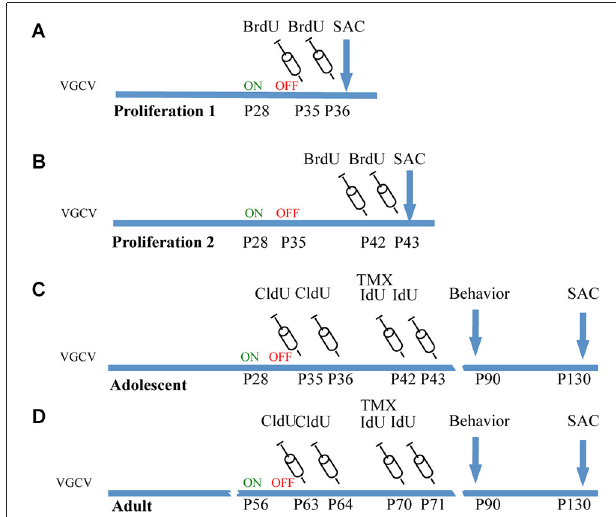
FIGURE 1 | Experimental cohorts of Nestin-CreERT2/R262R-Stop- EYFP/GFAP-Tk mice. (A) Proliferation 1. To observe the effect of VGCV on cell proliferation, Tk − / − and Tk + / − mice were treated with VGCV from P28-P35, injected with cell proliferation marker BrdU on P35 and P36 and sacrificed on P36. (B) Proliferation 2. To observe cell proliferation 7 days following cessation of VGCV, Tk − / − and Tk + / − mice were treated with VGCV from P28-P35, injected with cell proliferation marker BrdU on P42 and P43 and sacrificed on P43. (C) Adolescent cohort of mice: Tk − / − and Tk + / − mice were treated with VGCV from P28-P35, cell proliferation marker CldU was injected on P35 and P36 to assess the effect of VGCV and proliferation marker IdU was injected on P42 and P43 to assess recovery following VGCV cessation. Tamoxifen (TMX) was administered on P42 to indelibly mark the nestin lineage in Cre + mice. Behavioral testing was started on P90 and animals were sacrificed on P130. (D) Adult cohort of mice: Tk − / − and Tk + / − mice were treated with VGCV from P56-P63, cell proliferation marker CldU was injected on P63 and P64 to assess the effect of VGCV and proliferation marker IdU was injected on P70 and P71 to assess recovery following VGCV cessation. Tamoxifen (TMX) was administered on P70 to indelibly mark the nestin lineage in Cre + mice. Behavioral testing was started on P90 and animals were sacrificed on